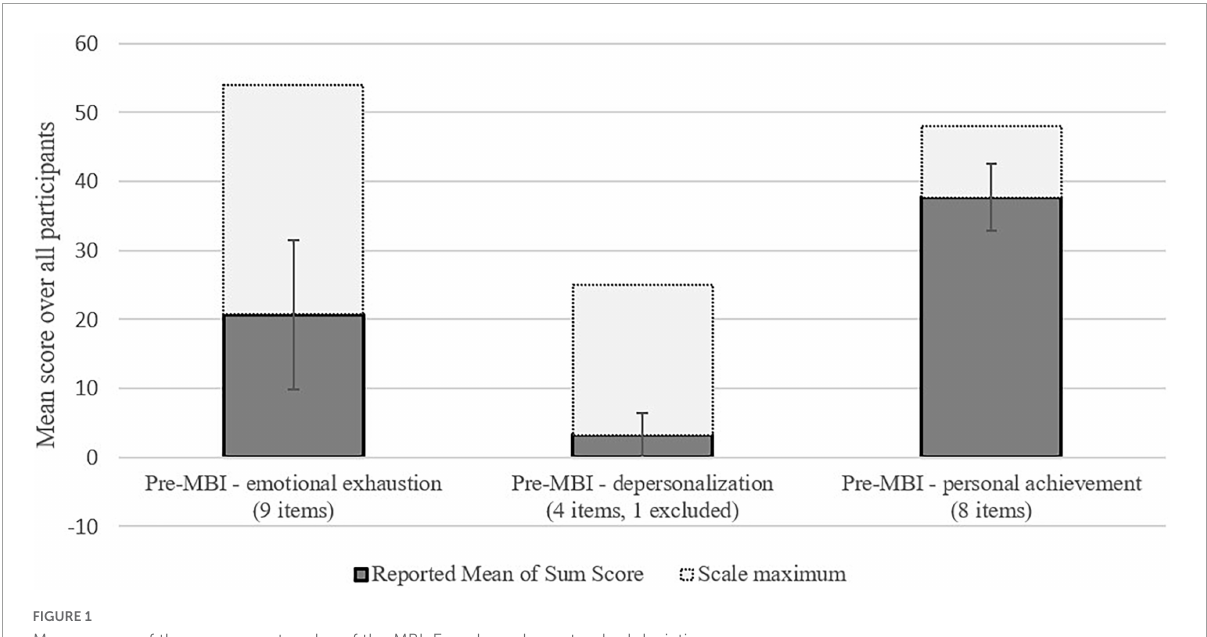
FIGURE1 Mean scores of the component scales of the MBI. Error bars show standard